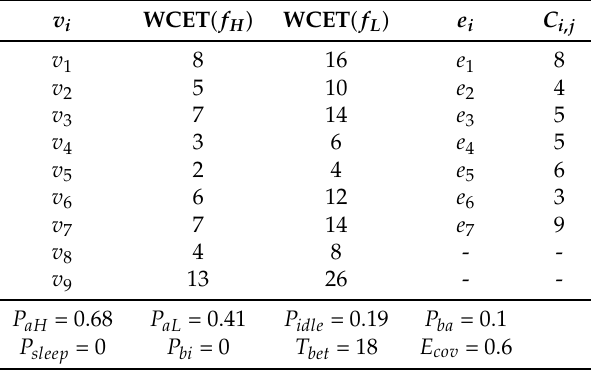
Figure 4. Task graphs and given mapping. Table 2. Task WCETs and power